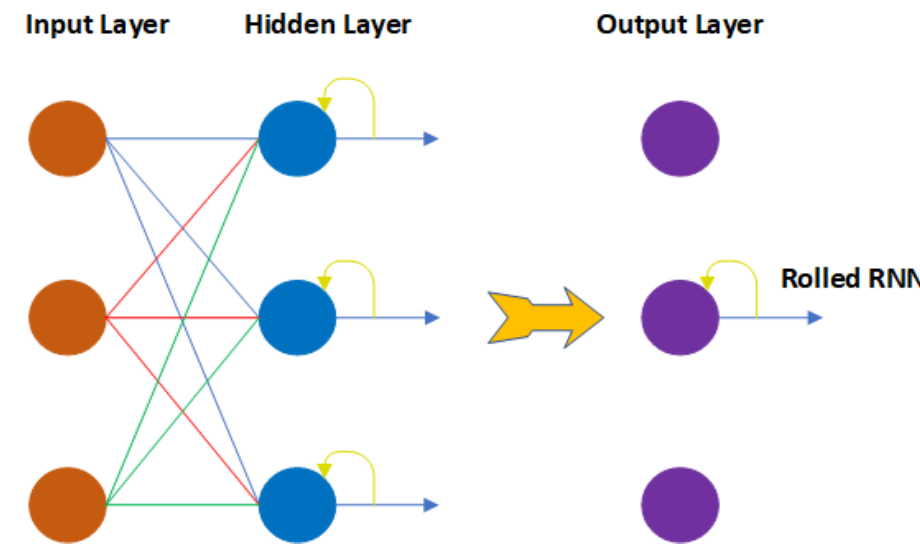
Figure 2. Conceptual representation of an RNN.